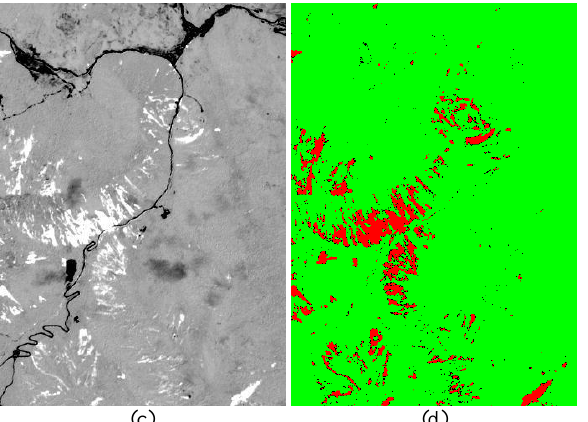
Figure 3. (a) Change detection image of bitemporal NDVI. (b) Training sample mask of δ NDVI . (c) Fourth component of PCA. (d) Training sample mask of